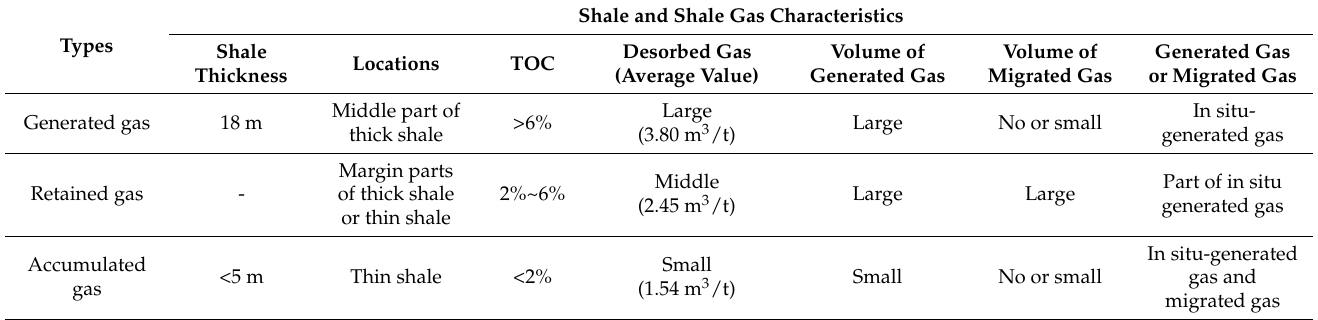
Table 2. Shale gas classification based on gas generation, migration and